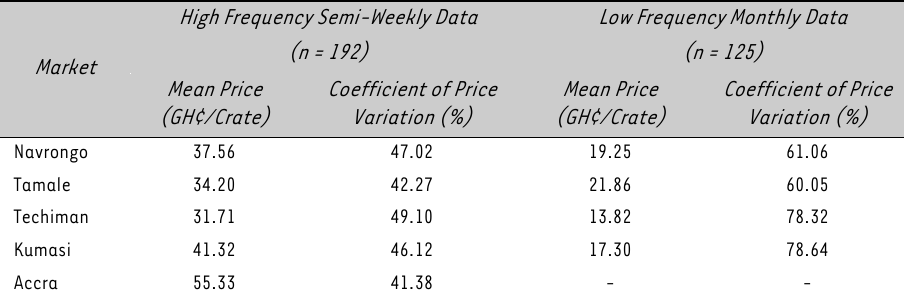
TABLE 1: Statistical Properties of the high and low frequency